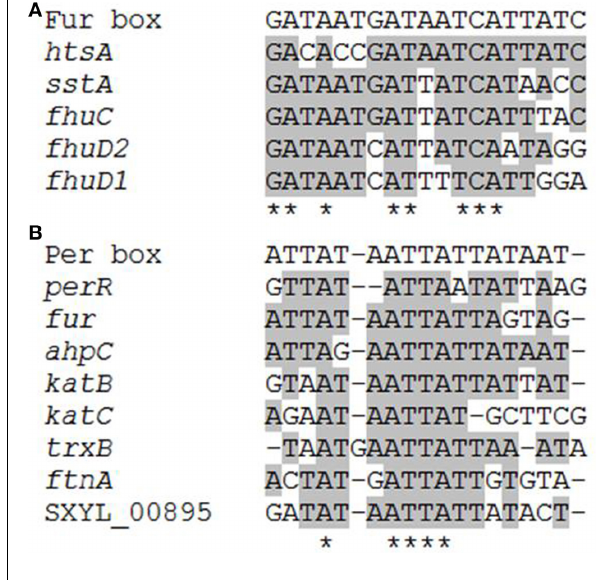
FIGURE 3 | Alignment of the putative Fur boxes (A) and PerR boxes (B) identified in the Staphylococcus xylosus C2a genes coding for iron homeostasis and antioxidant properties. ∗ Conserved